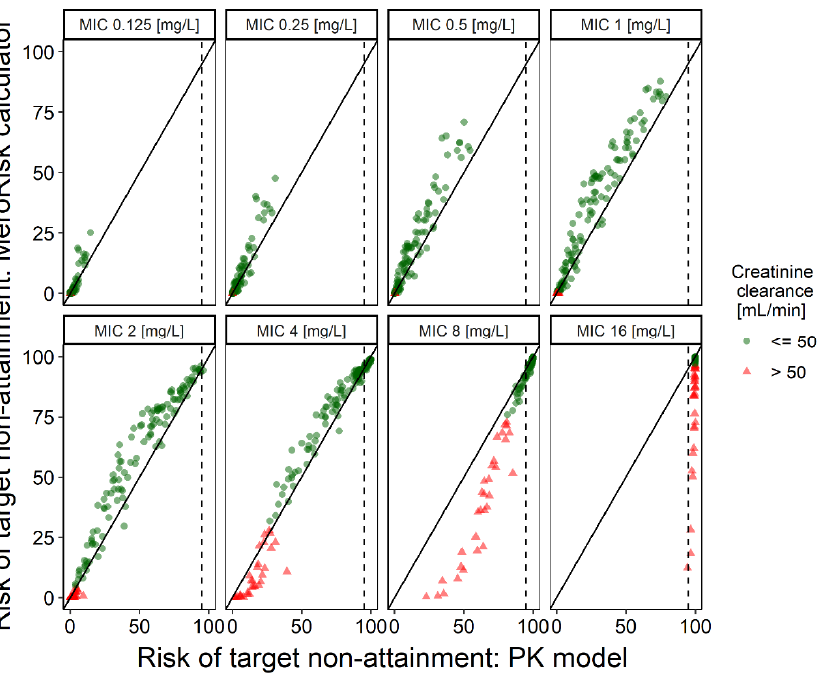
Figure 2. Risk of target non-attainment predicted by MeroRisk-Calculator and by pharmacokinetic (PK) model. The risk of target non-attainment (unbound drug concentration below the minimum inhibitory concentration (MIC) 8 h after standard dose (1 g meropenem, 0.5 h infusion)) was assessed for 155 critically ill patients and selected minimum inhibitory concentrations. Solid line: Line of identity, dashed line: 95% risk predicted by the PK model.